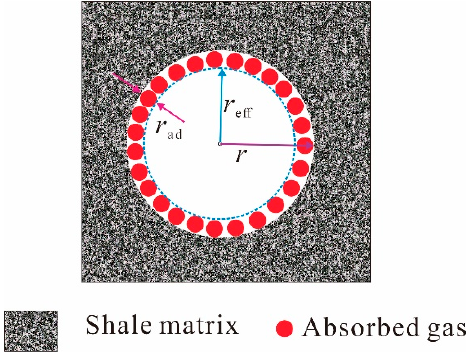
Figure 2. Effective hydraulic radius for organic pores. Figure 2. E ff ective hydraulic radius for organic